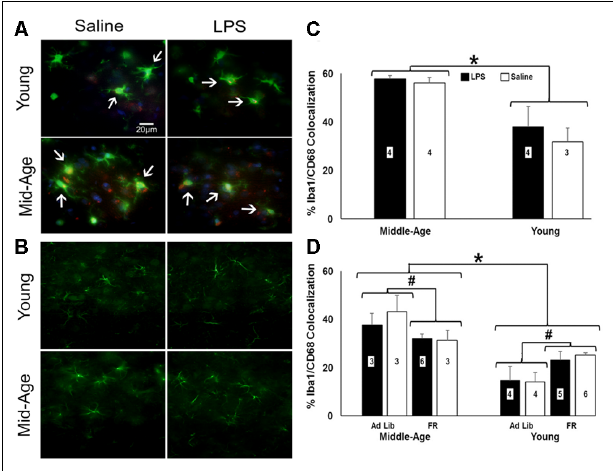
FIGURE 6 | Caloric restriction attenuates PFC microglial activation in middle-age yet instigates it in young. (A) Representative images of microglia stained for ionized calcium binding adaptor molecule (Iba-1; green) and CD68-positive (red) and (B) astrocytes stained for glial fibrillary acidic protein (GFAP; green) in the PFC of chronically-treated young and middle-age rats. Blue staining indicates DAPI. (C) Bar graph of the mean (+ SEM) percent Iba-1+/CD68+ colocalization for rats treated with LPS (filled bars) or saline (open bars). Middle-age rats exhibited heightened colocalization of Iba-1 and the phagocytic marker CD68, suggesting greater microglial activation in the aging PFC. Conversely, examination of food restriction’s impact on acutely treated rats demonstrated a mitigating effect of this age-specific increase (D) . Interestingly, young rats displayed the opposite pattern, in which they experienced an increase in Iba-1+/CD68+ colocalization with food restriction. Thus, food restriction may have elicited a potential stress response in young while relieving signs of neuroinflammation in middle-age rats. ∗ Main effect, p < 0.05; # interaction of food restriction and age, p <